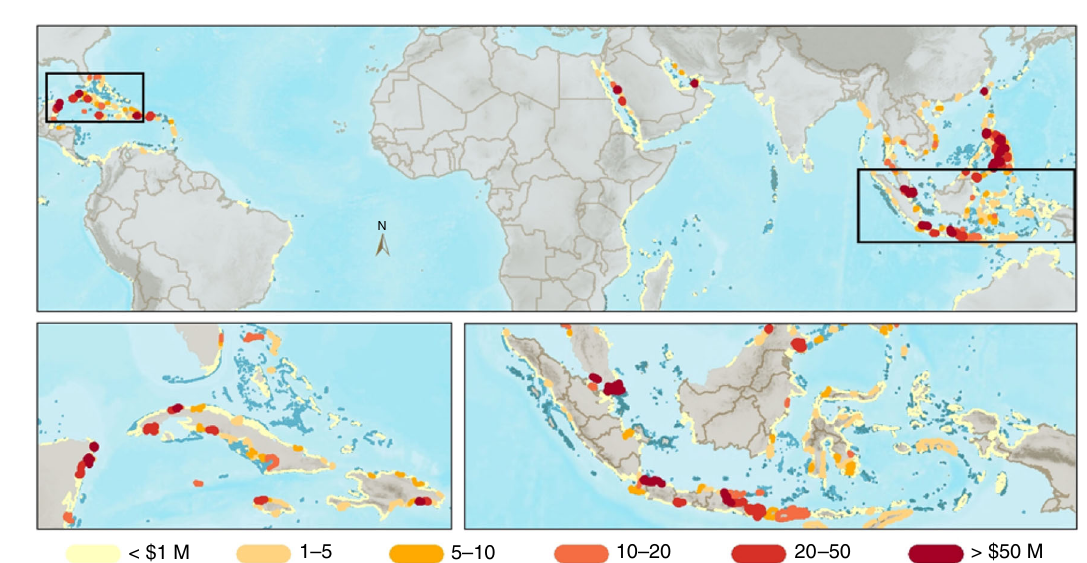
Fig. 5 The value of coral reefs for fl ood protection. Circles represent the annual expected bene fi t from coral reefs for fl ood protection ($US millions). The values are the difference in annual expected damages with and without (the top 1 m) of reefs for the 20 km coastal study